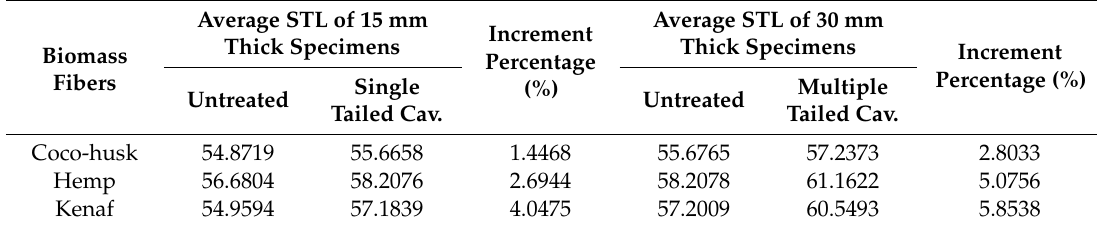
Table 5. The comparison of average sound transmission loss of biomass fiber materials.